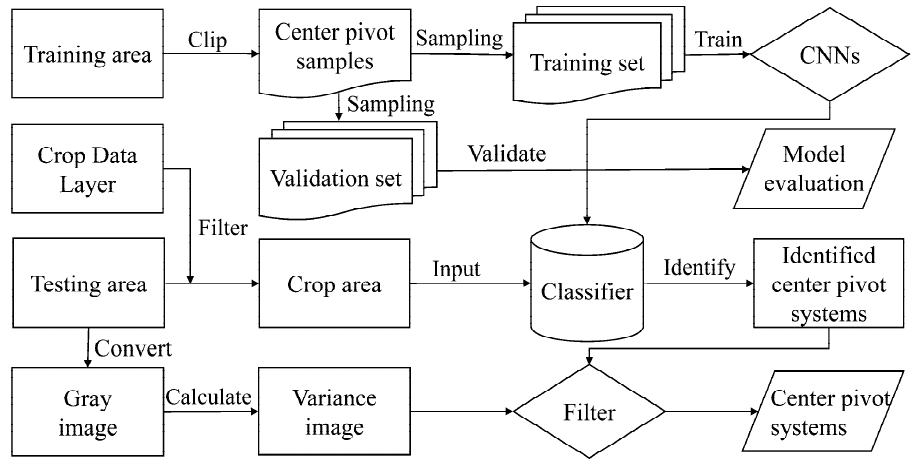
Figure 3. The framework for center pivot irrigation systems identification using Convolutional Neural Networks.